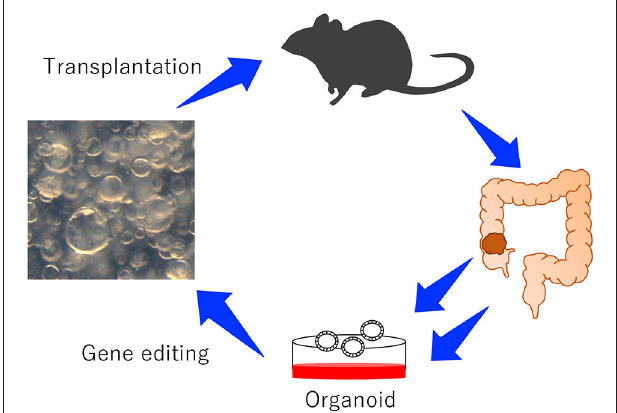
FIGURE 1 | An experimental system to study the function of CRC genes using mouse-derived organoids. Colonic organoids or colonic tumor organoids were established from wild-type mice or GEM, genetically manipulated, and transplanted to mice to induce tumor